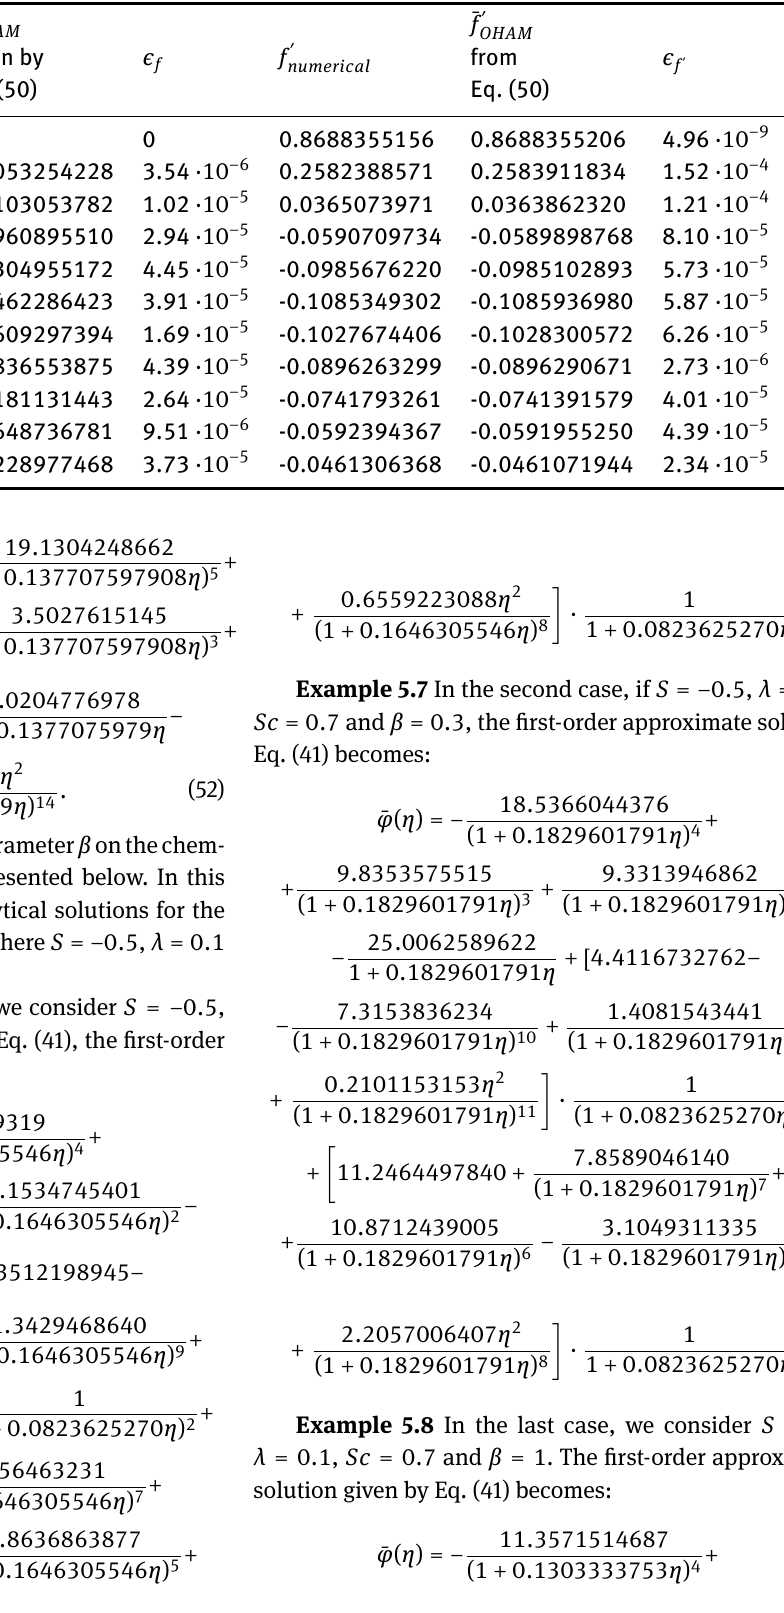
= | f ′ − ¯ f ′ | f ′ OHAM numerical